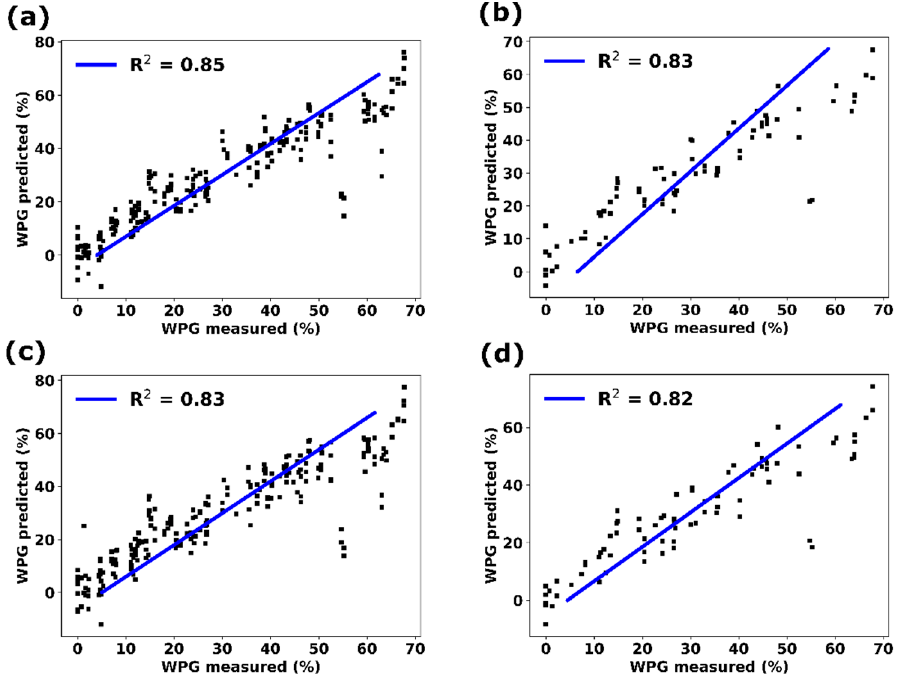
Figure 5. WPG of SorCA-treated wood collected from the radial plane and based on the PLS-R model prediction with no pre-treatment for the ( a ) cross-validation and ( b ) test set; after second derivative for the ( c ) cross-validation and ( d ) test set. for the ( c ) cross-validation and ( d ) test